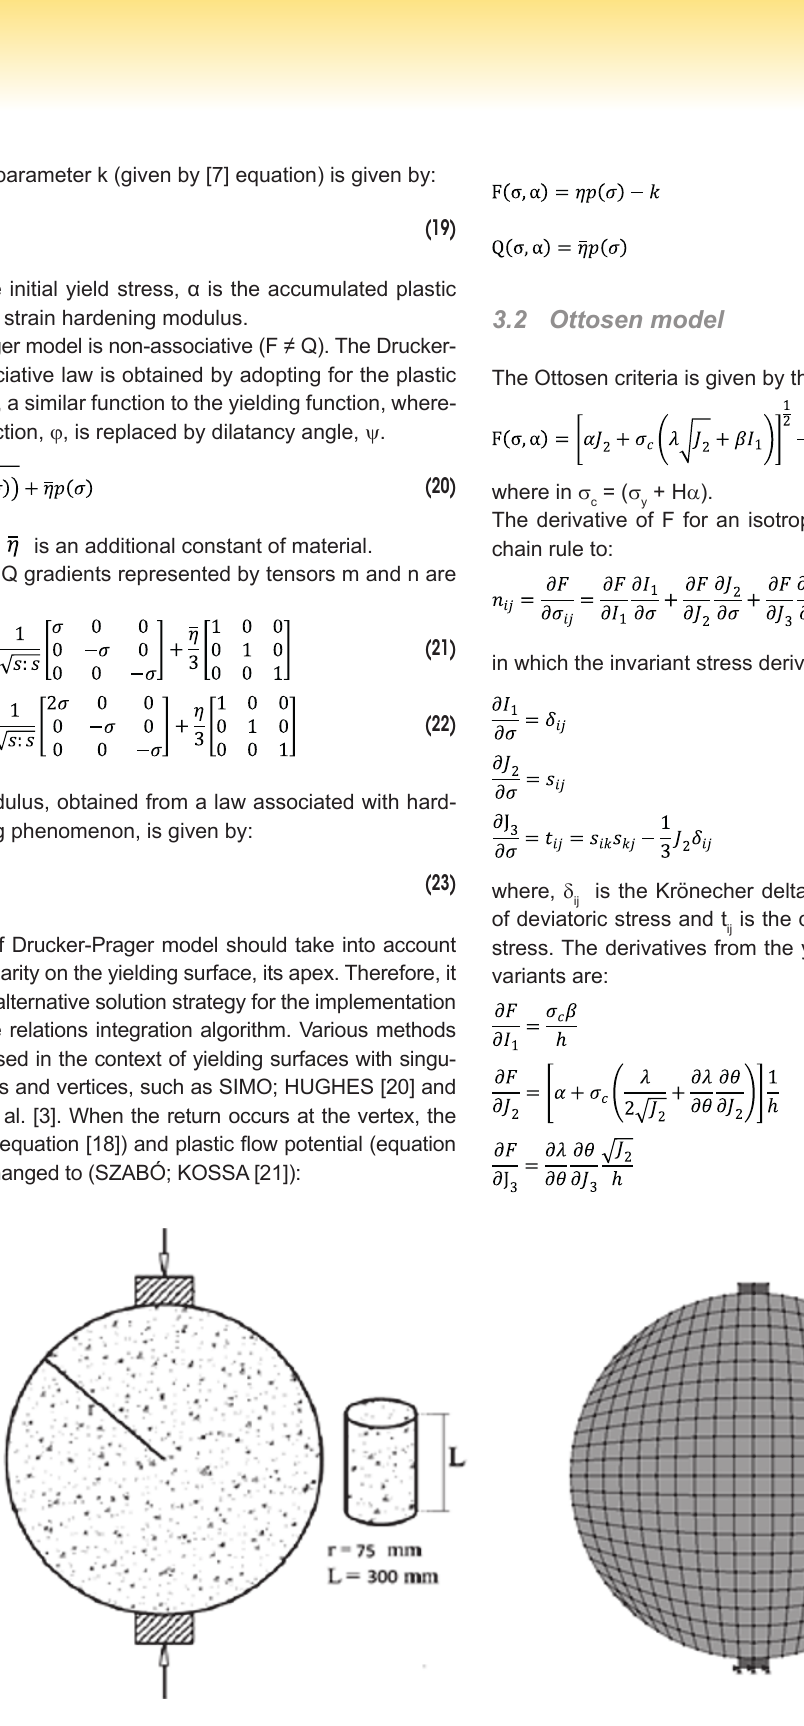
Figure 5 Geometry and finite element mesh for the diametral compression